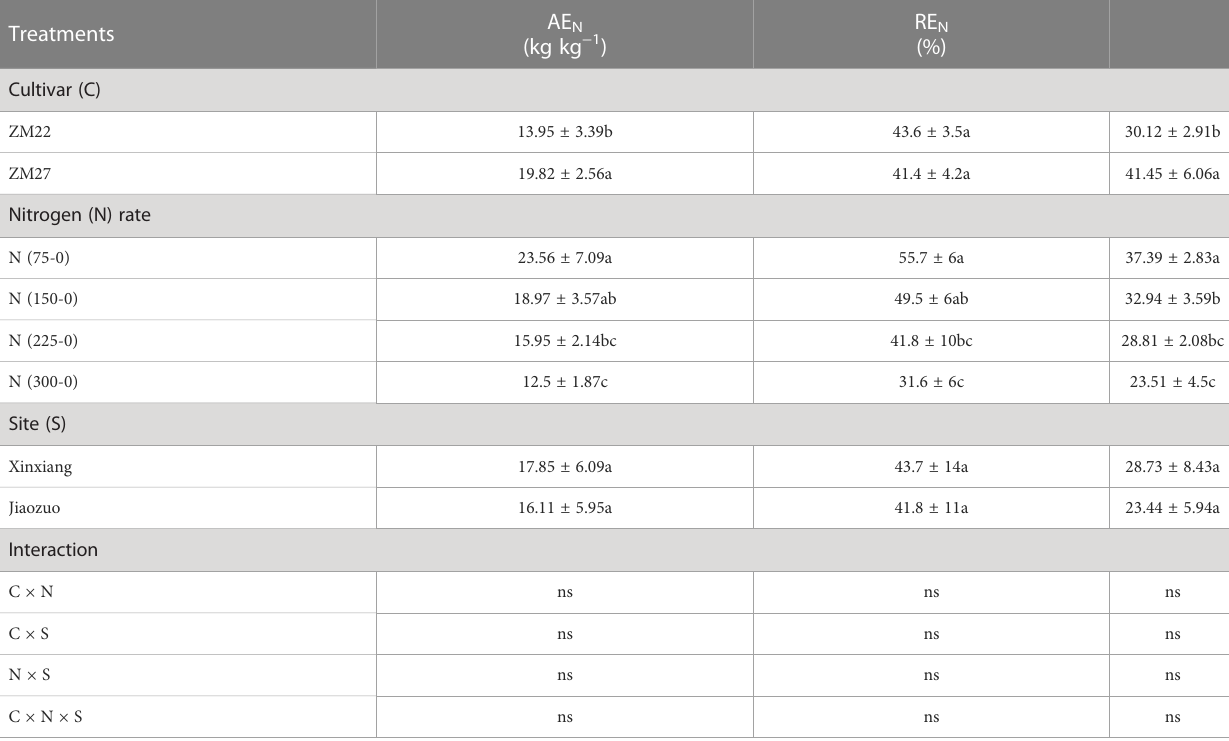
TABLE 3 N fertilizer agronomic ef fi ciency and its components for two cultivars under different N levels during the 2016 to 2017 growing seasons and the mean values of the two cultivars under the different N levels.